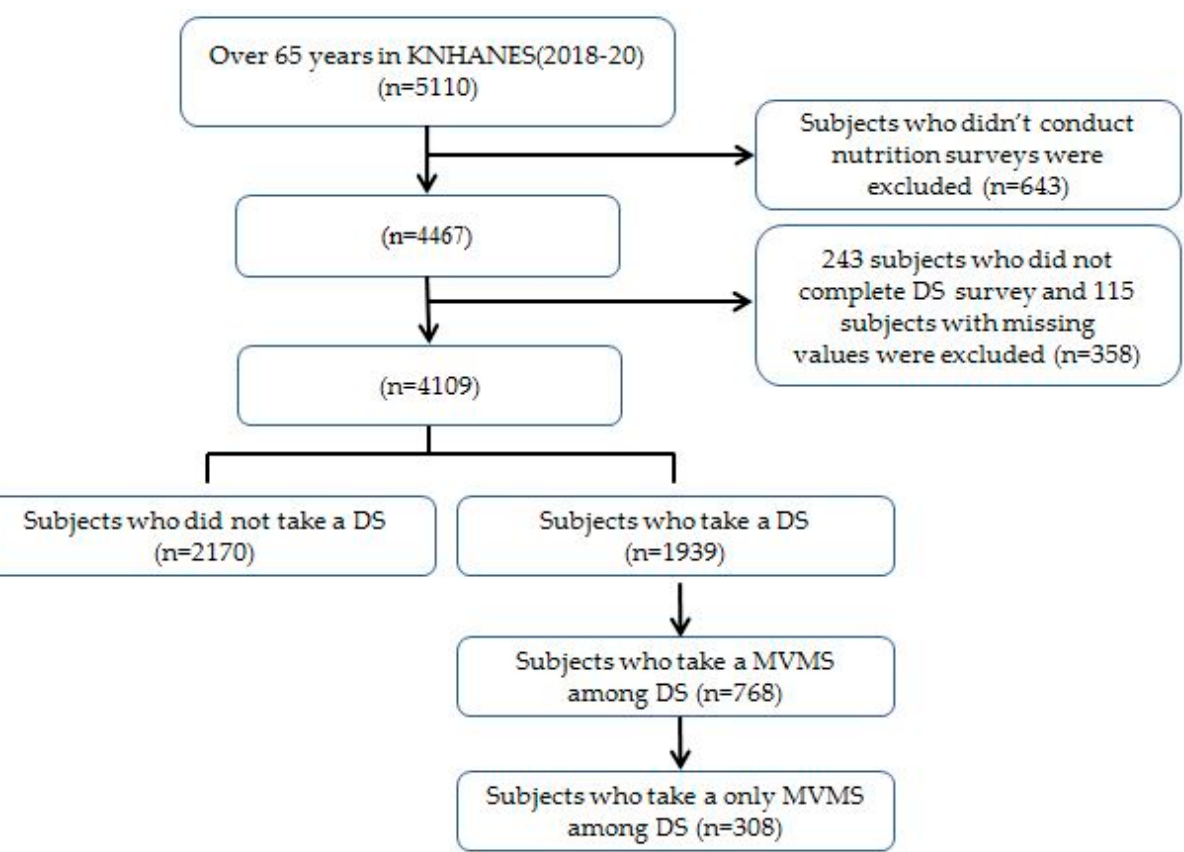
Figure 1. Flow chart of participations. Abbreviations: KNHANES, Korean National Nutrition and Health Survey; MVMS, multi-vitamin and mineral supplements; DS, dietary supplements.